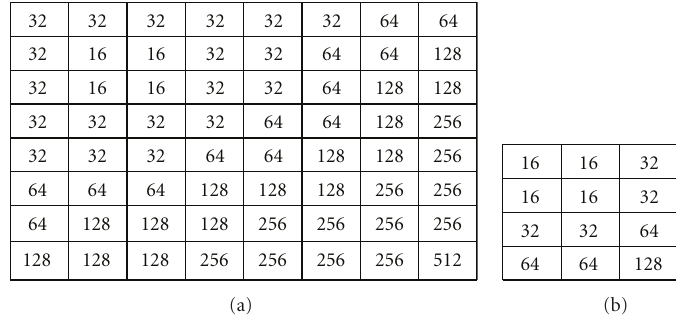
Pin g - p on g memo r